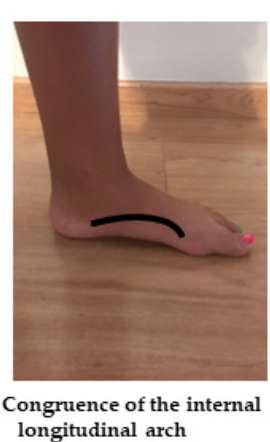
Figure 1. The six criteria of Foot Posture Index.